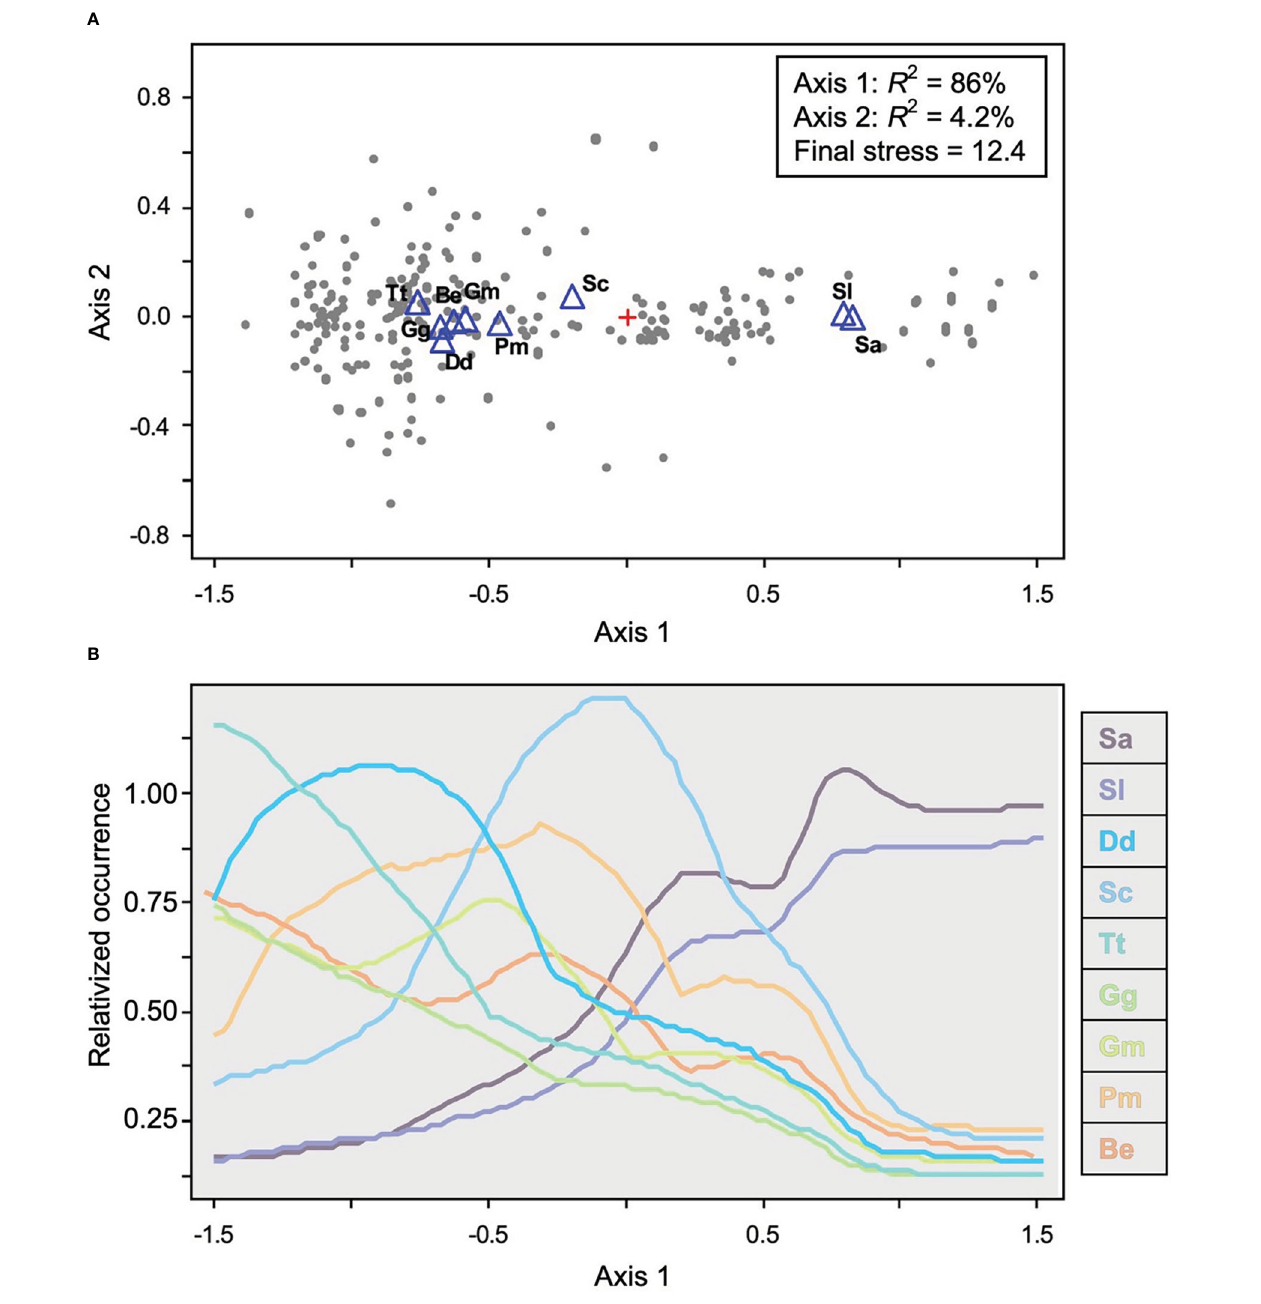
FIGURE 5 Non-metric multidimensional scaling ordinationof the Gala ́ pagos cetacean community,based onnine species with acceptablesample size. (A) Biplot ofthe ordination scores onthe two main axes, with gray dots correspondingto904 sampleunits (0.25-degree grid cells) where species occurrence was evaluated. Open blue triangles arethe averagepositions of the nine species, calculated by weighted averaging. (B) Cetaceancommunity gradient (coenocline) for the nine species in the ordination, showing species responses (relativized occurrence) along axis 1, the dominant environmental gradient. Curves correspond to an envelope that includes points fallingwithin two standarddeviations of a running mean along the axis. Sa, S.attenuata ; Sl, S. longirostris ; Dd, D delphis delphis ; Sc, S.coeruleoalba ; Tt, T. truncatus ; Gg, G griseus ; Gm, G macrorhynchus ; Pm, P. macrocephalus ; and Be, B edeni brydei . Adapted